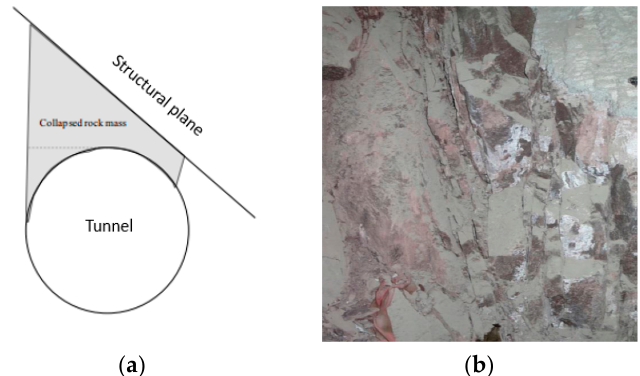
Figure 3. ( a ) Structural plane of “11.28” rockburst event in Jinping ‐ II drainage tunnel ( b ) Shear plane